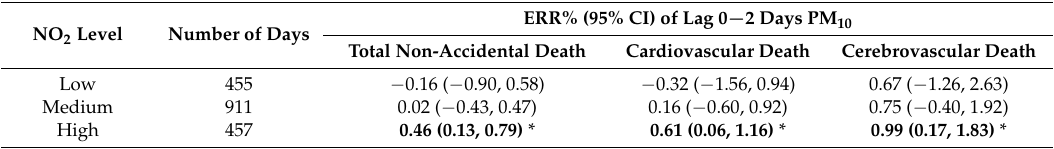
* The statistically significant effects are in bold. Cut-off points of NO 2 level are the 25th and 75th percentiles of lag 0–2 concentration (39.90 and 76.14 µ g/m 3 ). Table 5. ERRs (%) with 95% confidence intervals for mortality for each 10 µ g/m 3 increment of lag 0–2 days NO 2 across PM 10